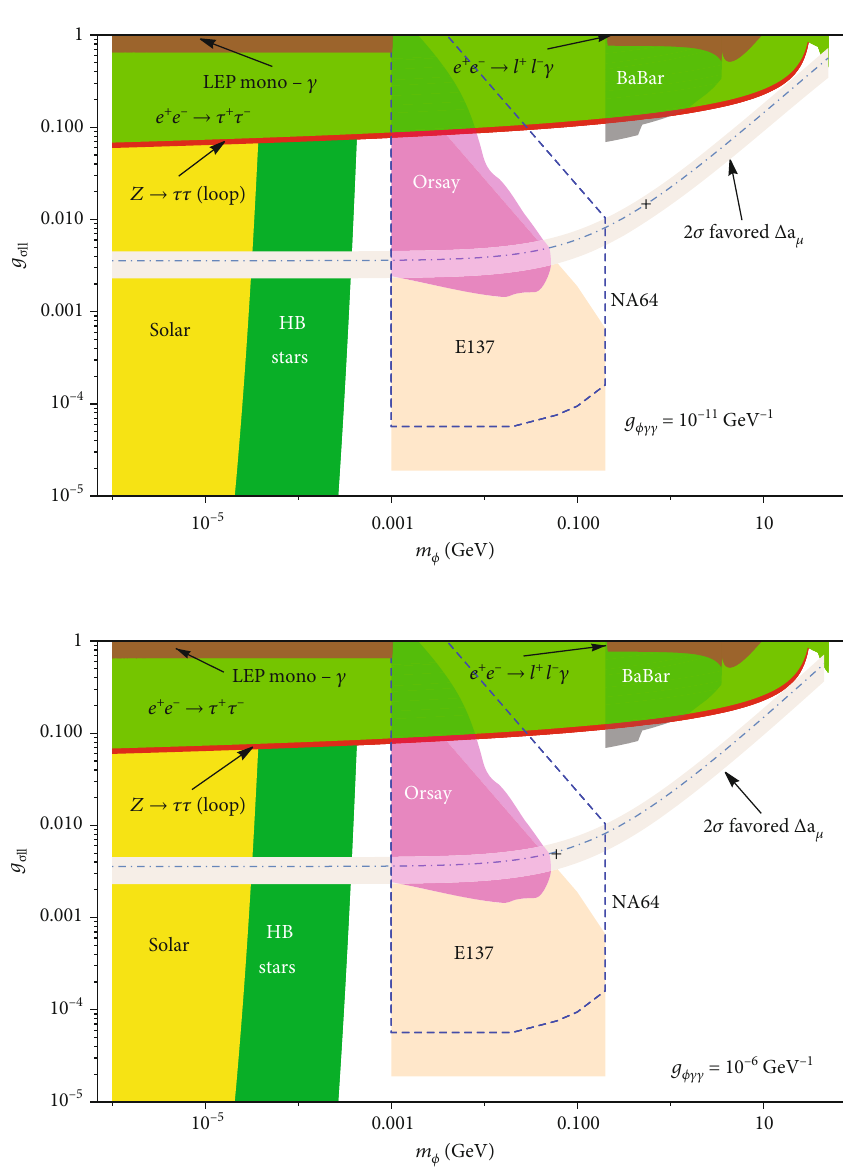
− 11 GeV − 1 (top) and g − 6 GeV − 1 (bottom) − g Figure 7: The exclusion plot of the m ϕ ϕ ll parameter space corresponding to the g ϕγγ = 10 ϕγγ = 10 benchmark points. The plot shows the 2 σ allowed region for Δ a μ ð (beige); the excluded region by the NLO correction to the leptonic Z decay e Þ (red), the excluded region due to the NLO corrections to ee → ττ (light green), Orsay (magenta), E137 (orange), LEP mono- γ and ee → ll + γ searches (brown), solar emission (yellow), and HB star emission (dark green); and the projected region for NA64 (dashed). The plots also show the favored points that correspond to the minimum χ 2 in the two